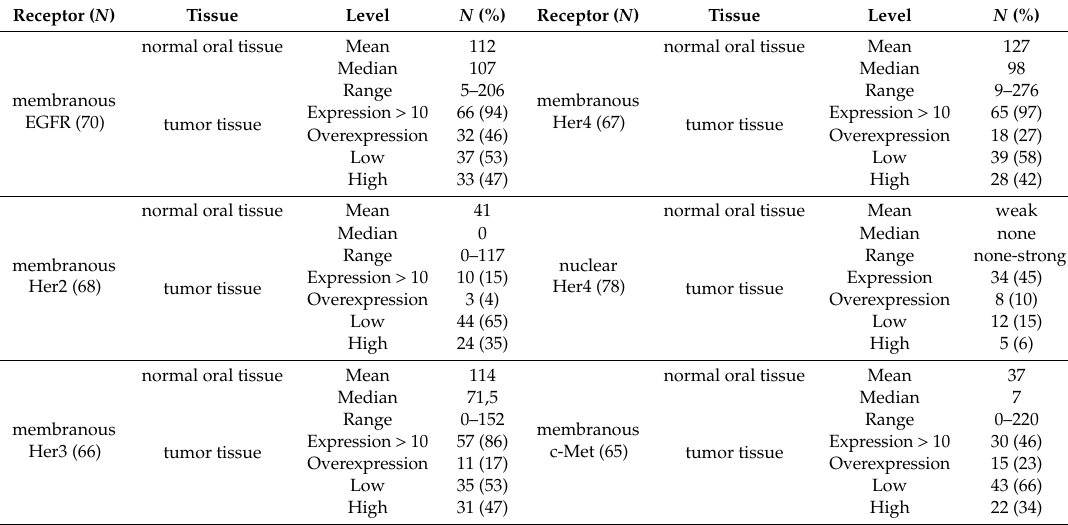
Table 2. Overview of expression data of EGFR, Her3, Her3, Her4 and c-Met in oropharyngeal squamous cell